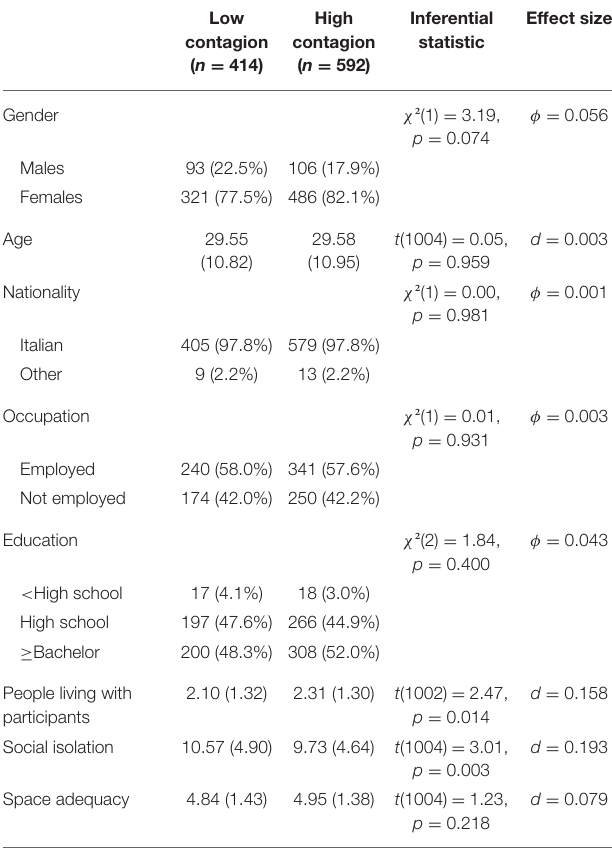
TABLE 1 | Descriptive statistics of and comparison between the low- and high-contagion